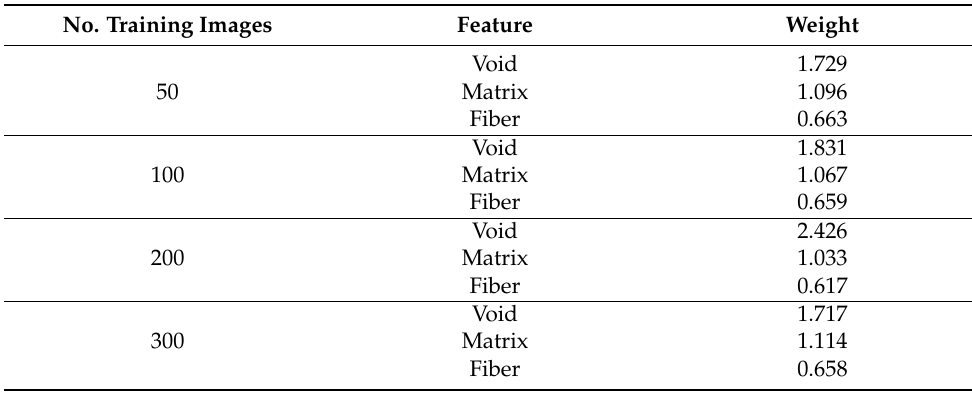
Table 6. The weights of each constituent in the different training